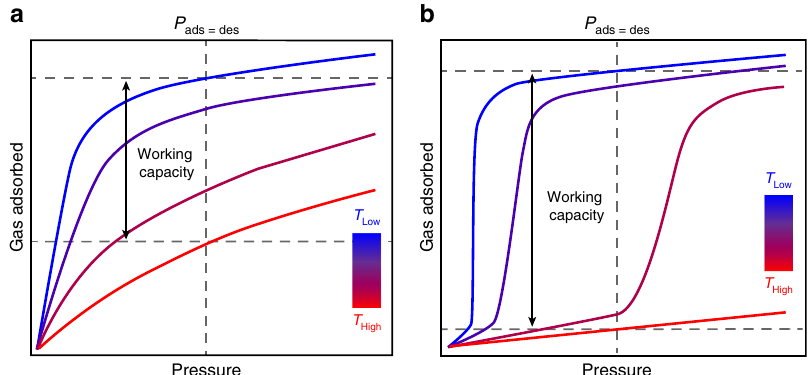
Fig. 1 Idealized gas adsorption isotherms. Comparison of the temperature-dependent adsorption behavior for a microporous material exhibiting a classical Type I Langmuir adsorption and b cooperative step-shaped adsorption (Type V). Relative working capacities achieved with both types of porous materials when P ads = P des are indicated by double-headed arrows. Importantly, cooperative adsorption pro fi les allow for greater working capacities with smaller temperature